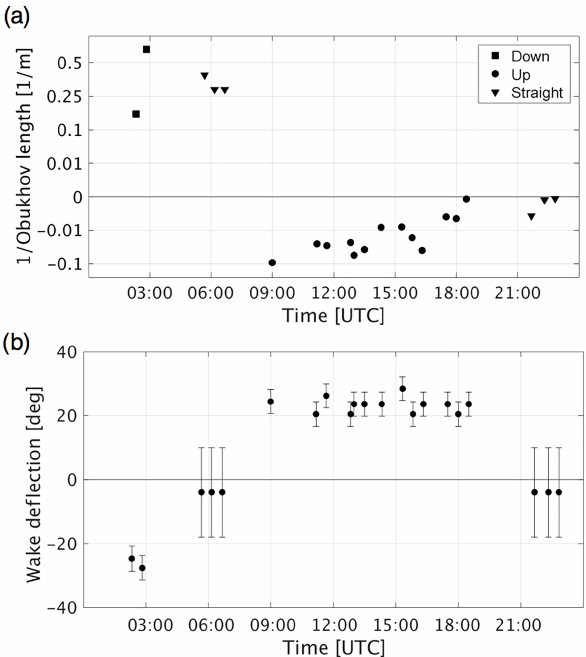
Figure 11. Short-range WindScanner wake measurements: (a) upward-moved wake (10min period from 19:20 to 19:30UTC, 11 May 2015) and (b) downward-moved wake (10min period from 00:50 to 01:00UTC, 12 May 2015); further examples are presented in Hansen et al. (2016). Black circle: projected rotor